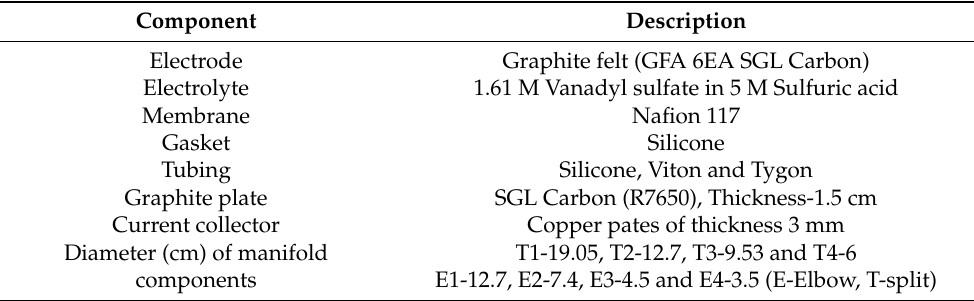
Table 1. Details of materials used in stack